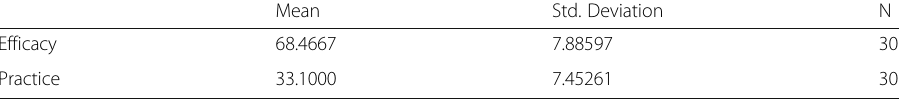
Table 7 Descriptive Statistics for Hard Discipline Teachers ’ Self-efficacy and Instructional Practice Mean Std. Deviation